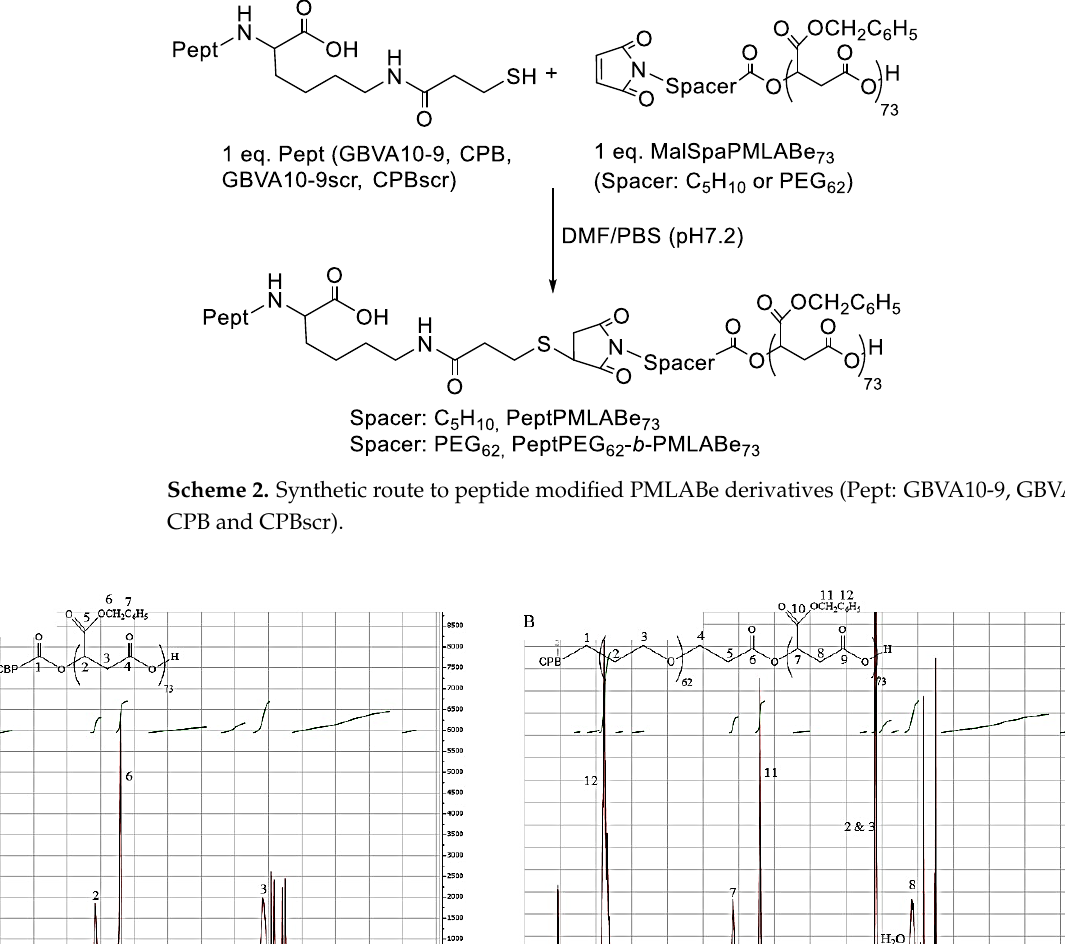
Figure 5. 1 H NMR spectrum of: ( A ). CPBPMLABe 73, and ( B ). CPBPEG 62 - b -PMLABe 73 .